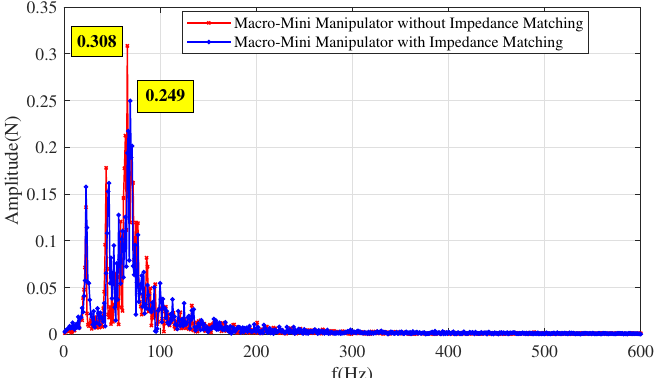
Figure 22. The vibration of the contact force at steady state when spindle